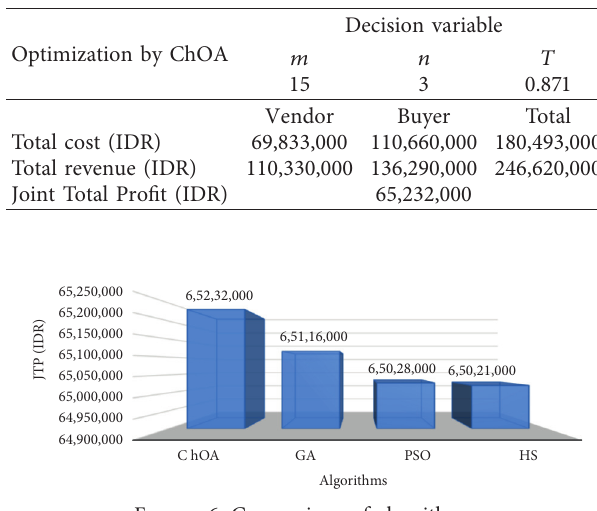
Table 2: Results of I-SVSB-IP optimization with